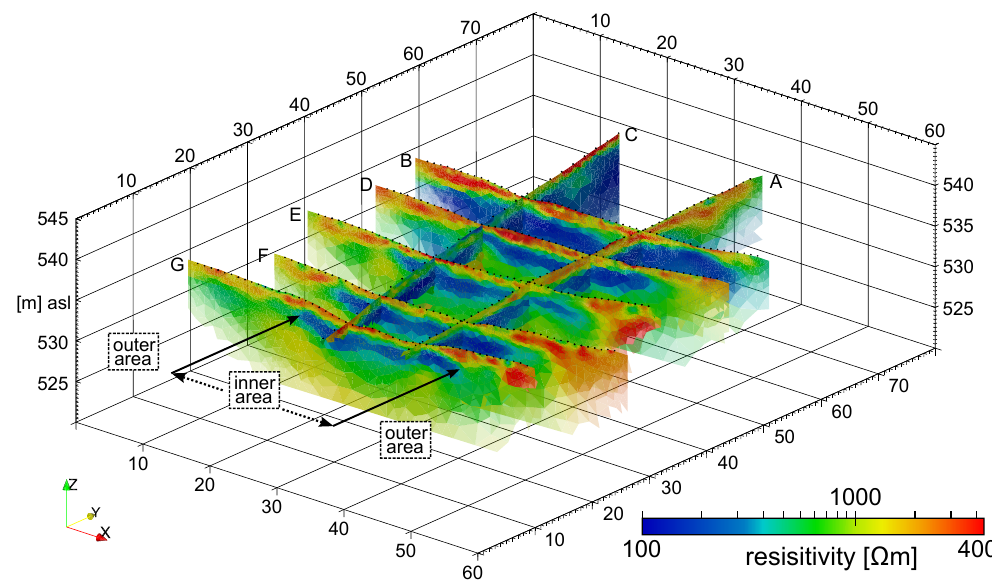
Figure 4. Resistivity results from ERT mapping (October 2008) of the study area: pseudo 3-D view of the profiles A to G.